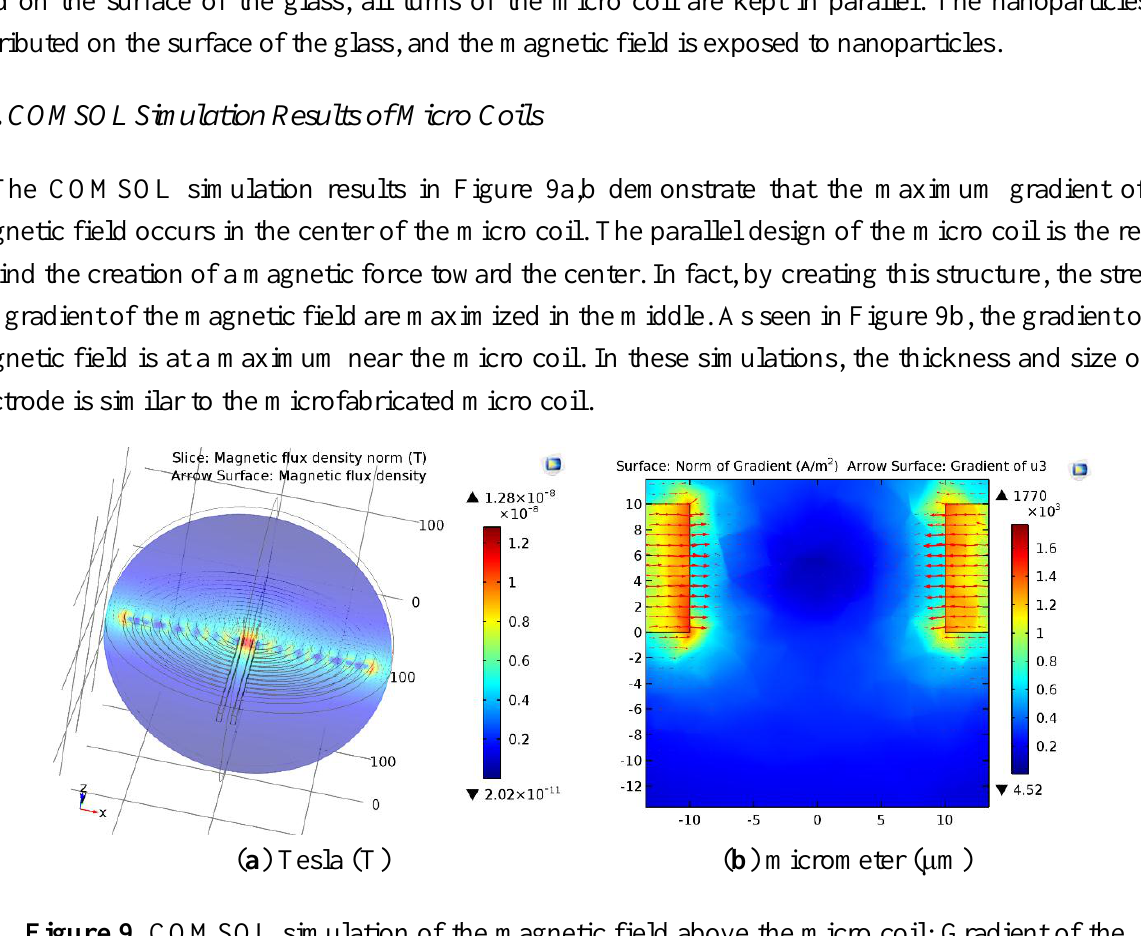
Figure 9. COMSOL simulation of the magnetic field above the micro coil; Gradient of the magnetic field ( a ) from the top and ( b ) close to the